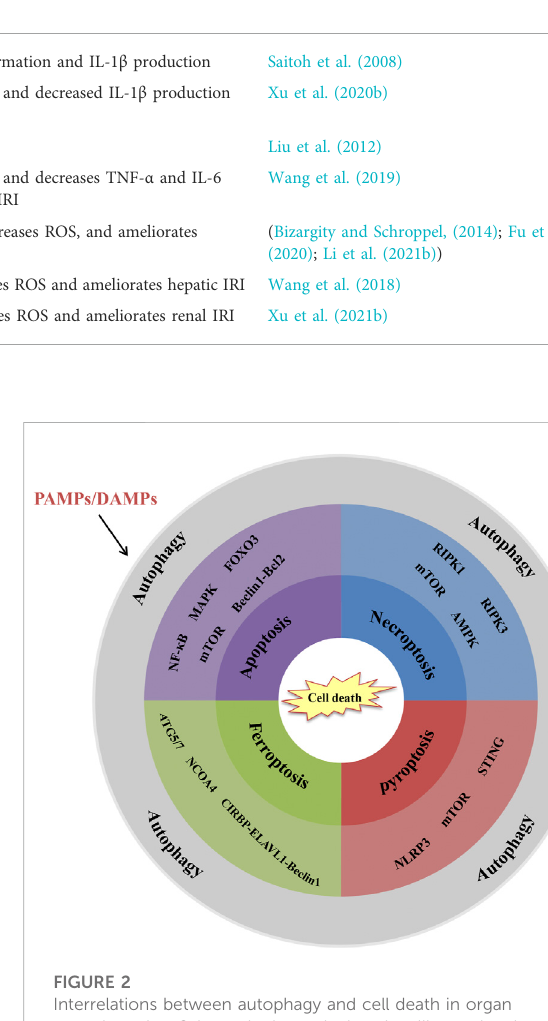
TABLE 1 Regulation of in fl ammation response and oxidative stress in organ transplantation by autophagy. Autophagy-related gene/ signalling